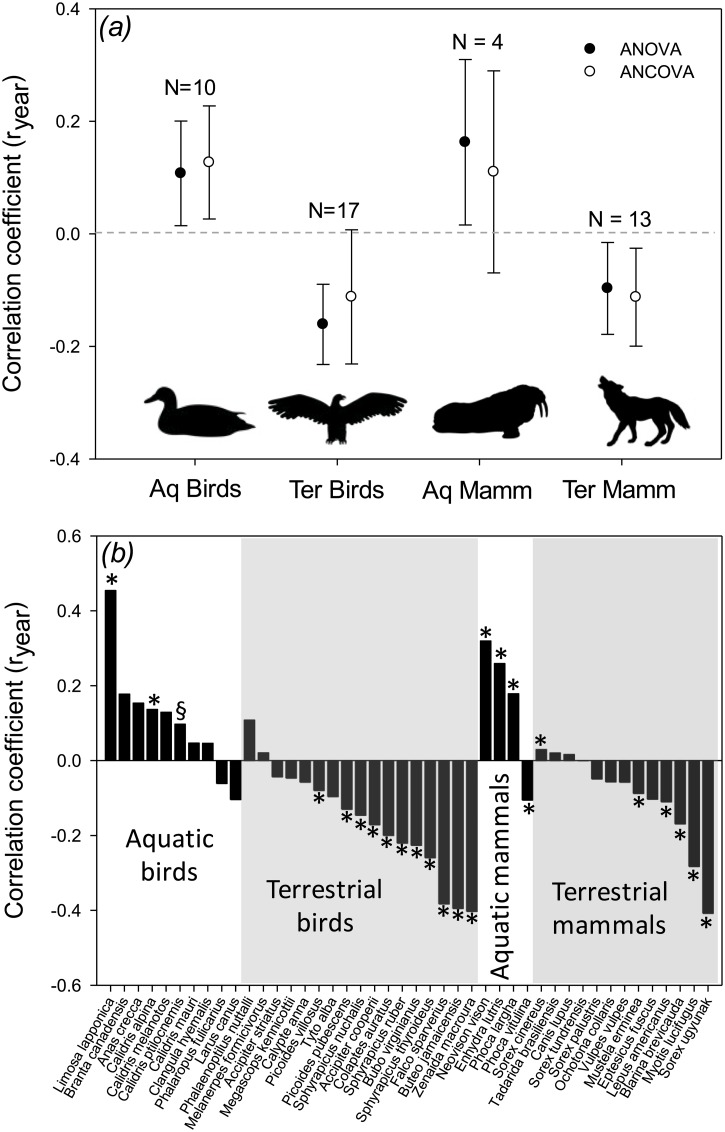
Correlation coefficient between body size and year of collection for (a) the four species groups that were compared, and (b) all the species included in the analysis.Aq Birds: aquatic birds, Ter Birds: terrestrial birds, AqMamm: aquatic mammals, Ter Mamm: terrestrial mammals. N = number of species in each group. Bars: 95% confidence intervals. * denotes P < 0.05 and § denotes P < 0.1.